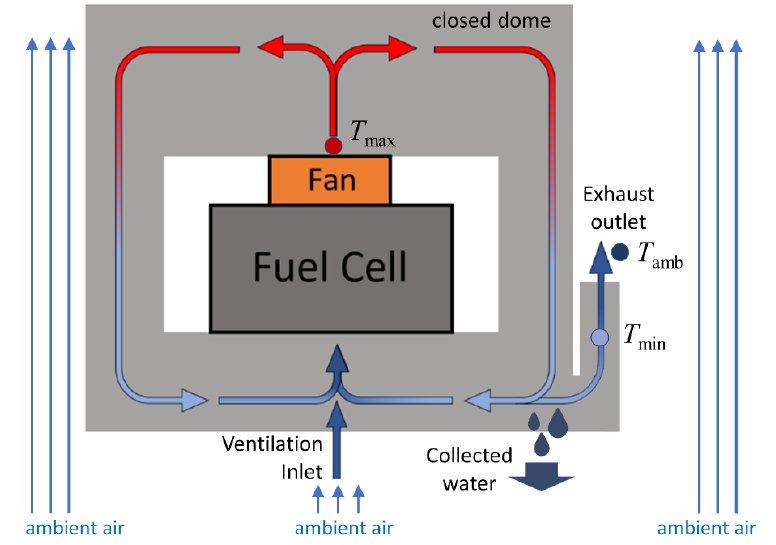
Figure 1. A schematic de scription of the WRS with the recirculating air in the dome’s internal channels, including the fuel cell, the fan, and the inlet ventilation and outlet exhaust ports.